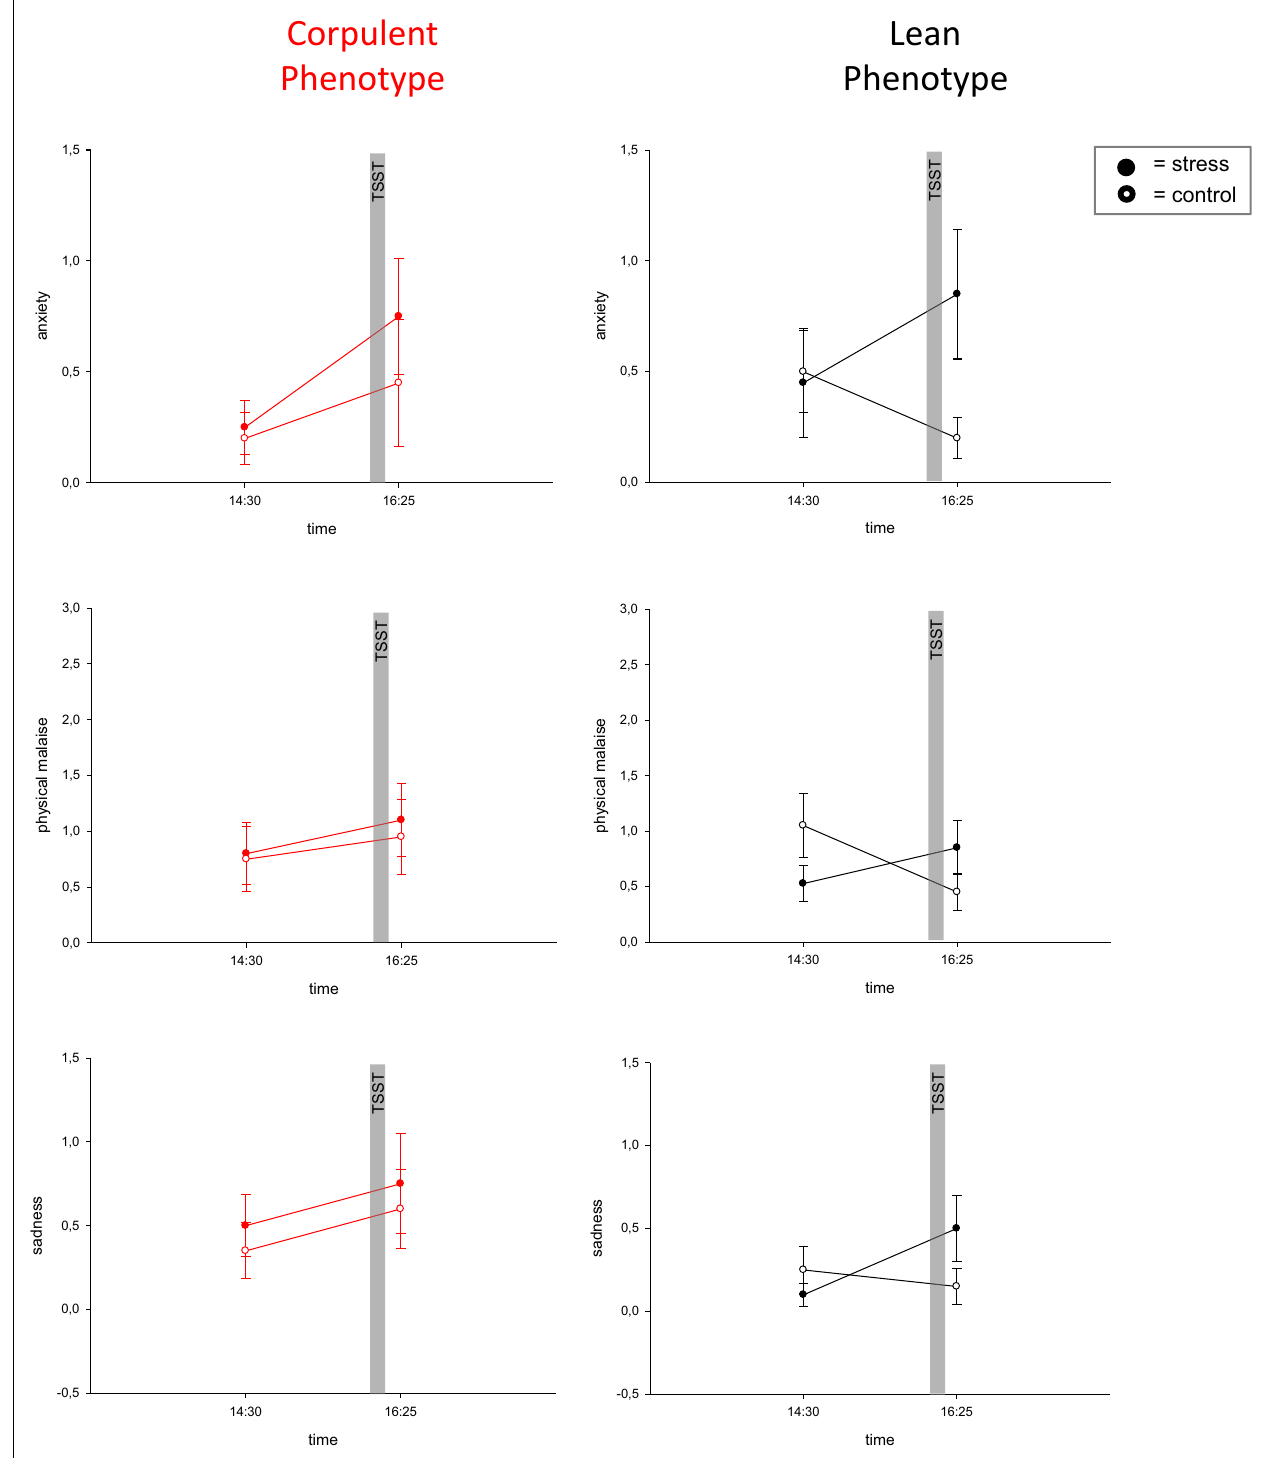
FIGURE 4 | Blunted emotional arousal during stress in the corpulent phenotype. Values are means ± SEM; closed symbols, stress intervention and open symbols, non-stress intervention. While lean subjects showed emotional arousal in all symptoms, corpulent subjects remained in their prevailing state of emotion. A nxiety: interaction time × stress intervention: F = 0.373, P = 0.086 (corpulent phenotype),